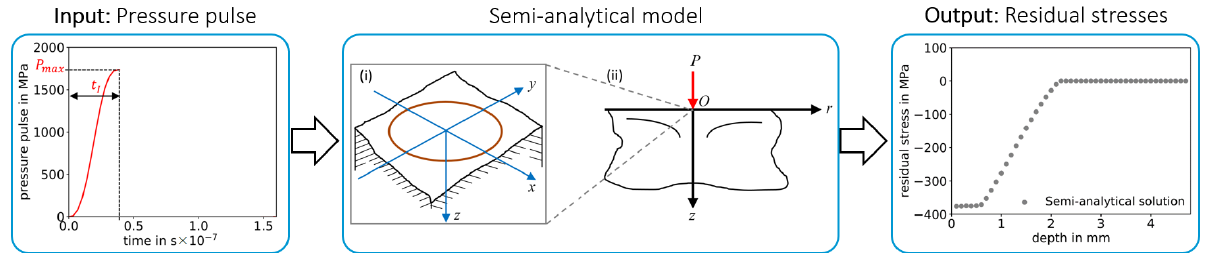
Figure 2. Illustration of the semi-analytical model by Hu et al. [23] for computing residual stresses induced by pressure pulse from Figure 1. Circular pressure pulse area (i) (in red) on the half-space model, which is simplified in (ii) as a concentrated normal load (in red) in the axisymmetric half-space model. Figures (i) and (ii) are republished with permission of the American Society of Mechanical Engineers ASME from